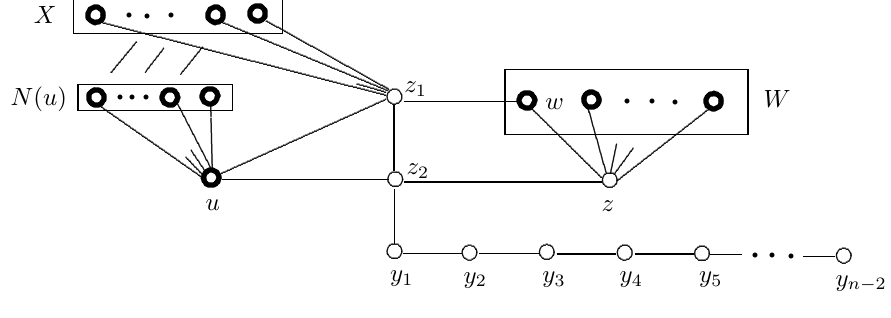
Figure 5: The graph G in the proof of Theorem 3.1.